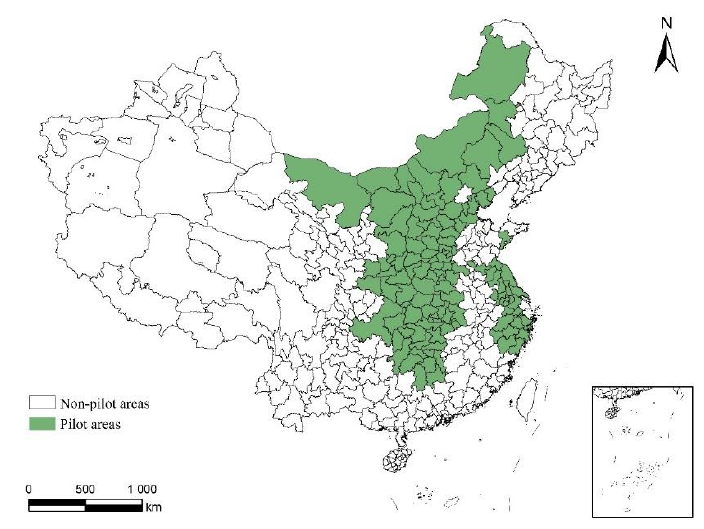
Figure 1. Distribution of ETS pilot areas in China.